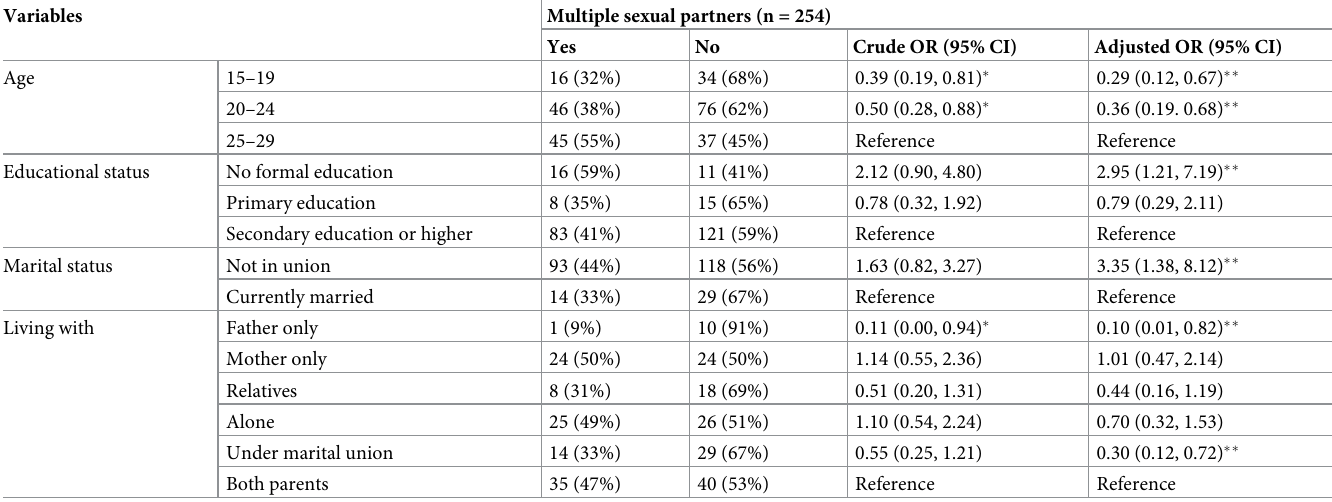
Table 4. Bivariate and multivariable logistic regression analysis for having multiple sexual partners among youth in Addis Ababa, Ethiopia,